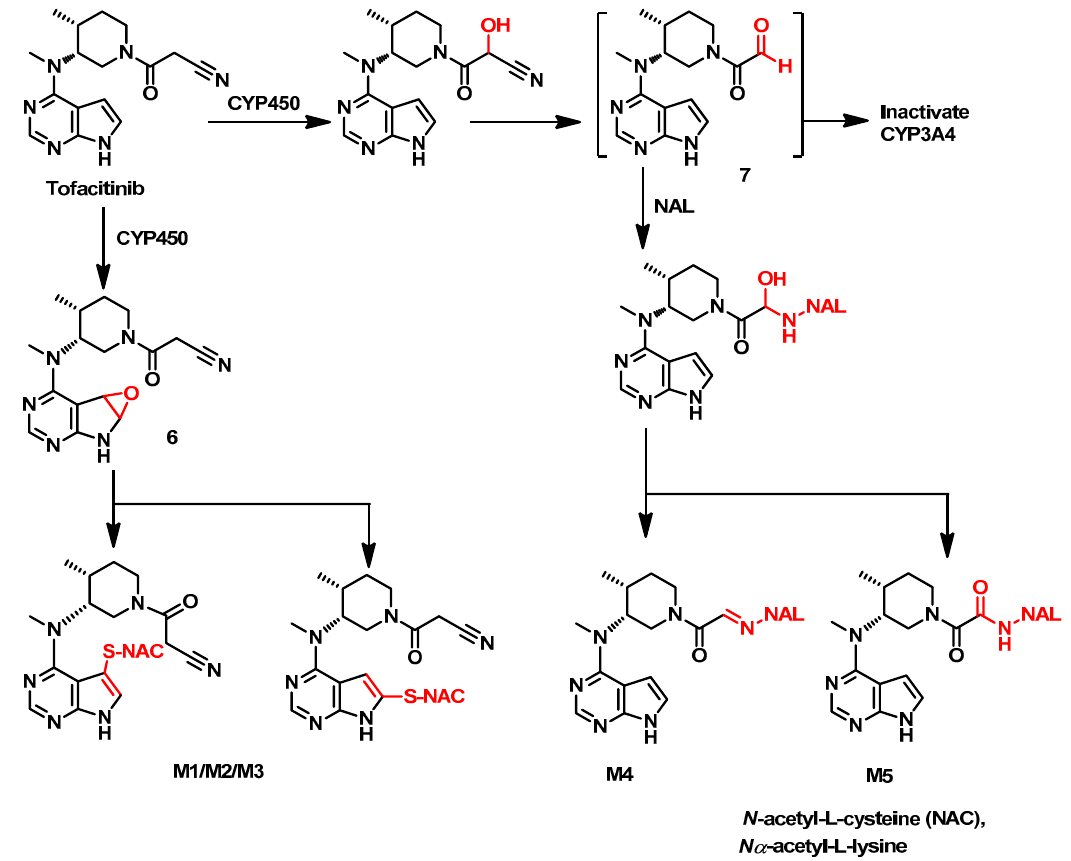
Figure 65. Proposed metabolic pathways and metabolites of tofacitinib.